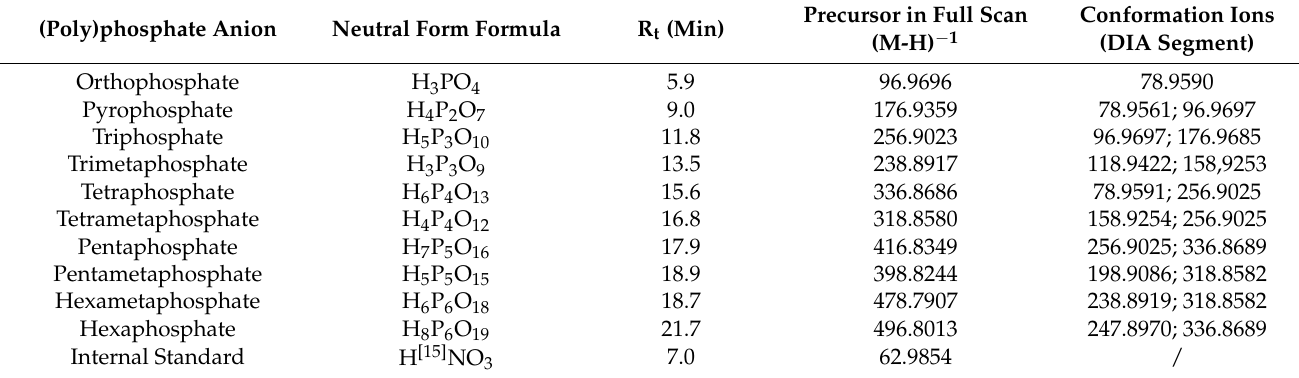
Table 1. Exact HPIEC–HRMS Q-Exactive Orbitrap mass database of the (poly)phosphate anions studied: elemental compositions, retention time (Rt), precursor and confirmation fragments of the parent pseudomolecular anions. (Poly)phosphate Anion Neutral Form Formula R t